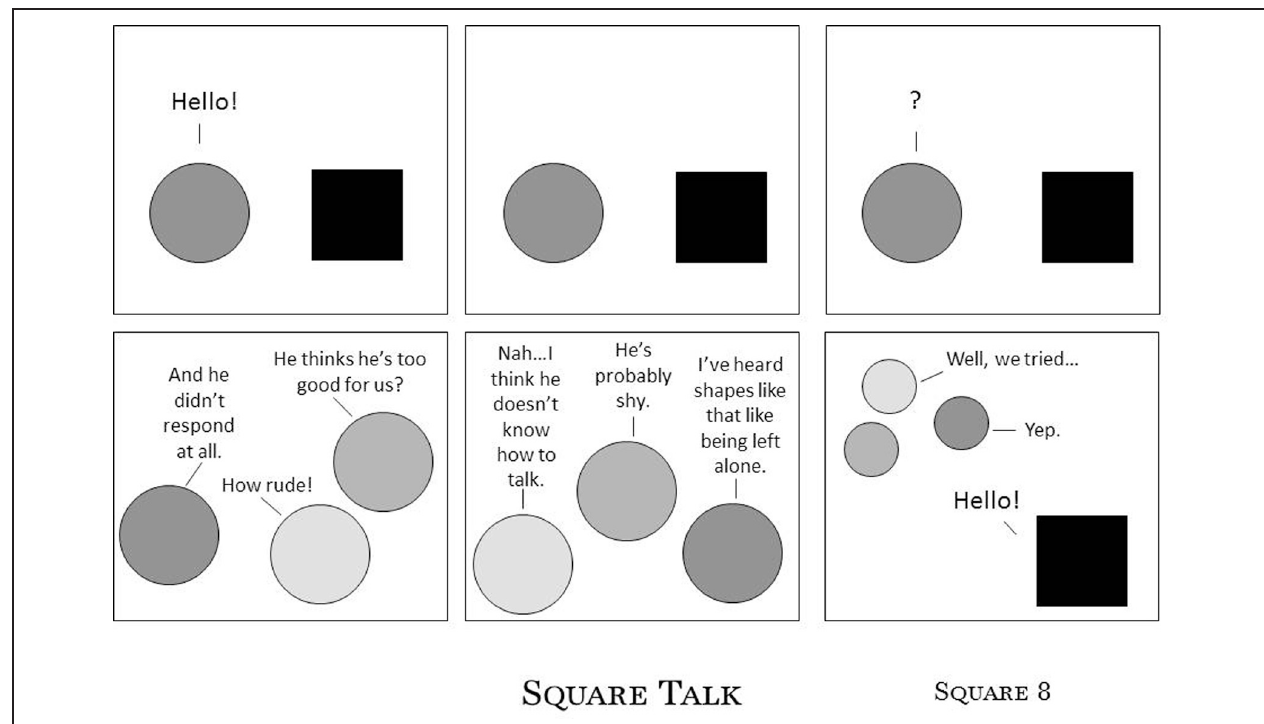
FIGURE 1 | Square Talk. Harp (2008), reprinted with